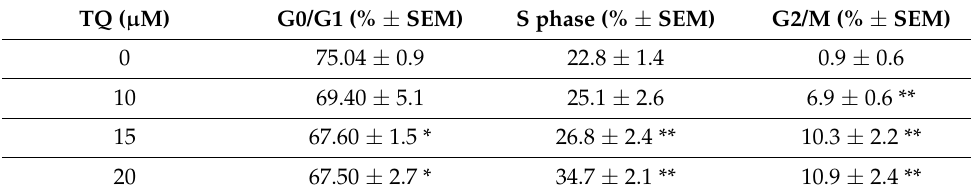
Table 2. The mean distribution of cell cycle phases in control TNBC